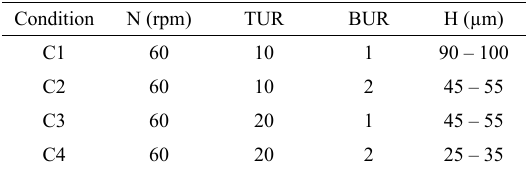
Table 1. Processing conditions of the blown films. N = screw rotation, TUR = take-up ratio, BUR = blow-up ratio and H = films'